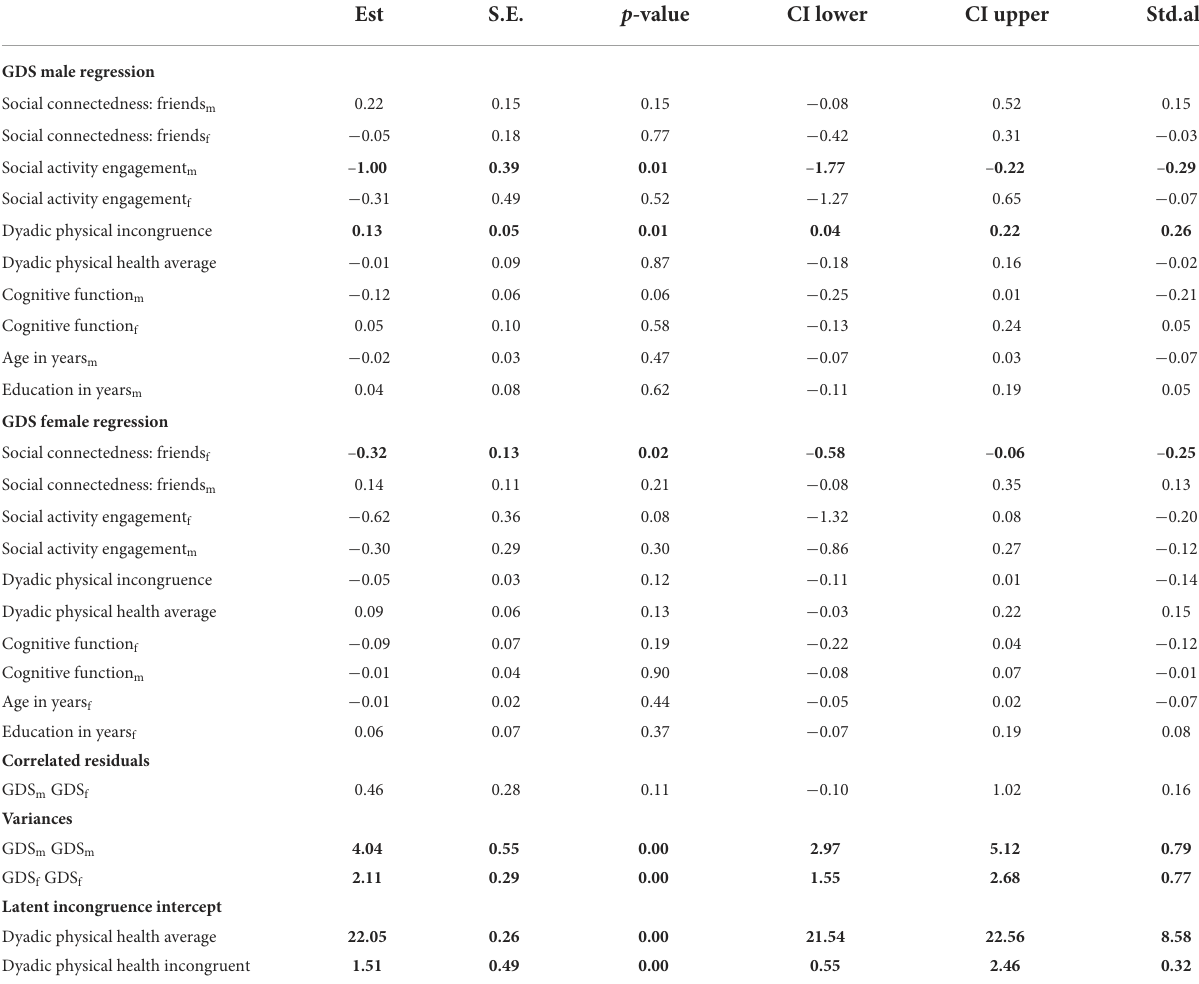
TABLE 3 Associations between social factors and depressive symptoms within the context dyadic physical health. Est S.E. p -value CI lower CI upper